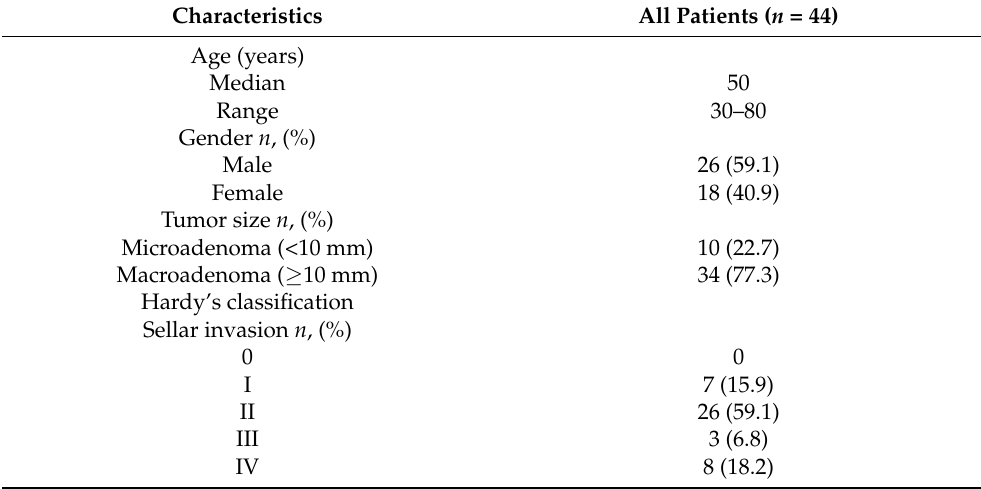
Table 1. Patient’s